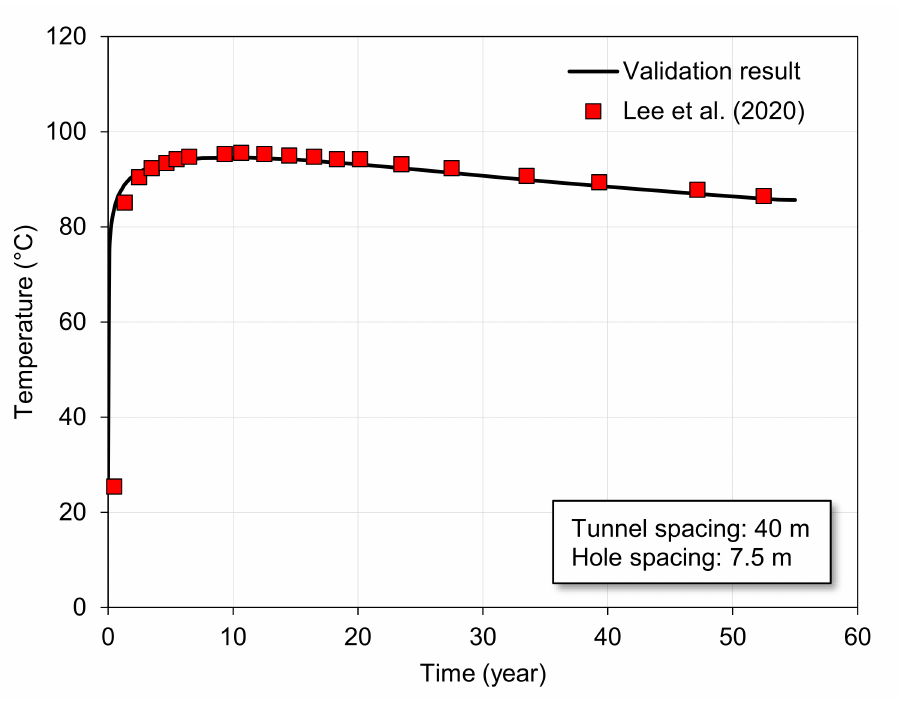
Figure 5. Validation result compared to the reference result for temperature of the buffer based on the R-SNF condition.